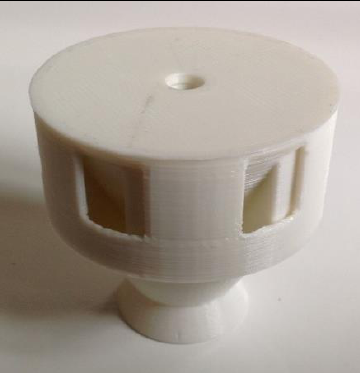
Figure 11. A nozzle block prototype (shown on the left) and a control sleeve (diaphragm) prototype in the position for reversible rotation of the turbine impeller.